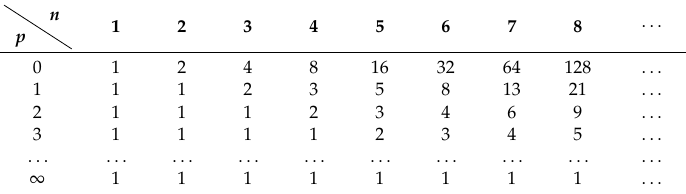
Table 1. Coding sequences corresponding to different p